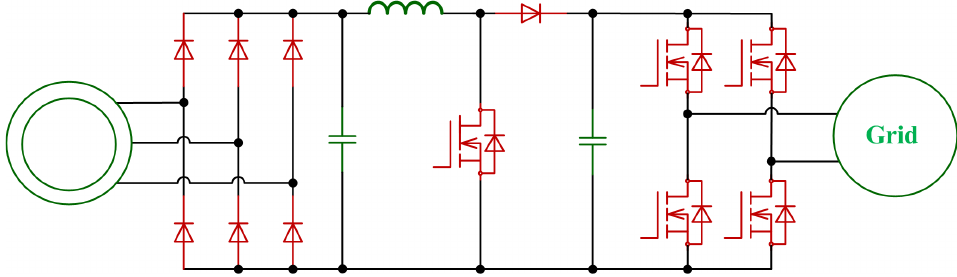
Figure 3. Diode bridge + boost converter wind generation system.